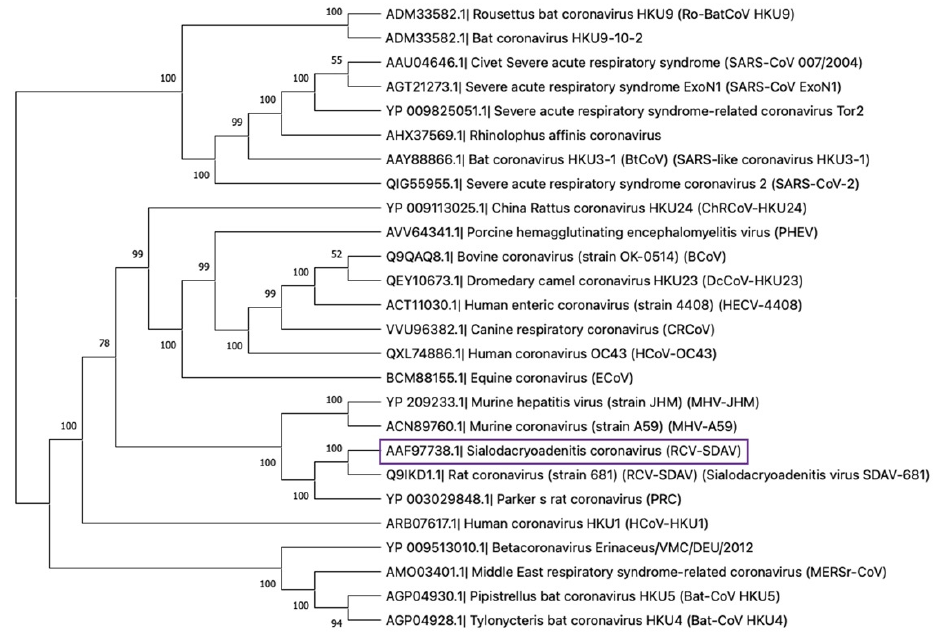
Figure 2. The neighbor-joining tree involves 26 amino acid sequences of spike glycoprotein of betacoronaviruses. The tree was constructed using the p-distance model and 1000 bootstraps in the MEGA X. 10.2.6. The SDAV is indicated in purple.